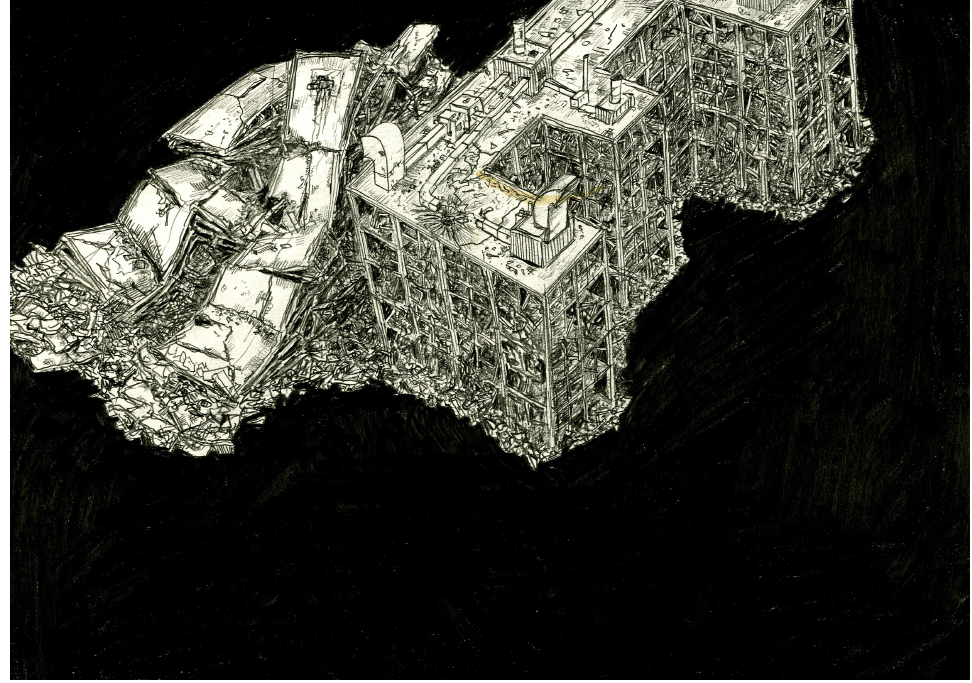
Figure 2: Andy, How dare you assume I want to parlez-vous with